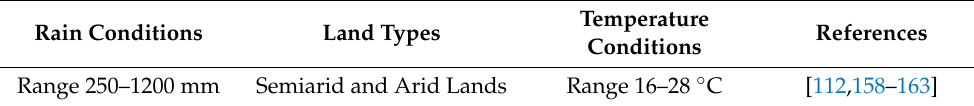
Figure 11. Possible areas of the Jatropha Curcas plantation in Pakistan. Table 9. Conditions for Jatropha Curcas plantation.